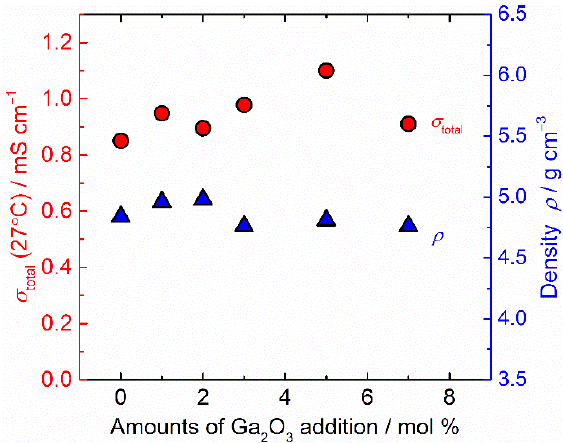
Figure 5. Density ρ and total ionic conductivity σ total at room temperature of all sintered samples are plotted against the amounts of Ga 2 O 3 addition.